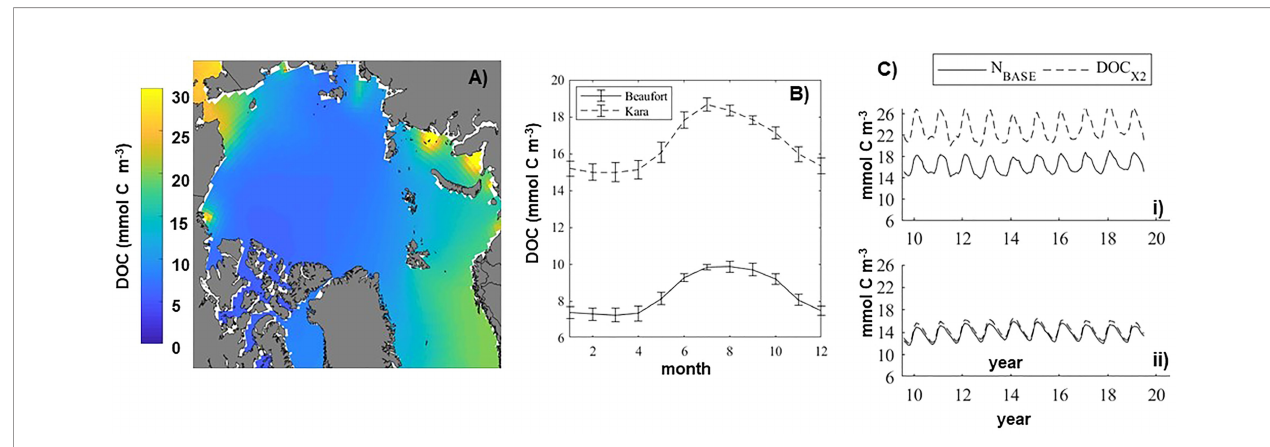
( Table 4 and Figure 8C ). The more marginal Arctic coastal regions (i.e. Chukchi and Barents) only saw a very small (~3%)